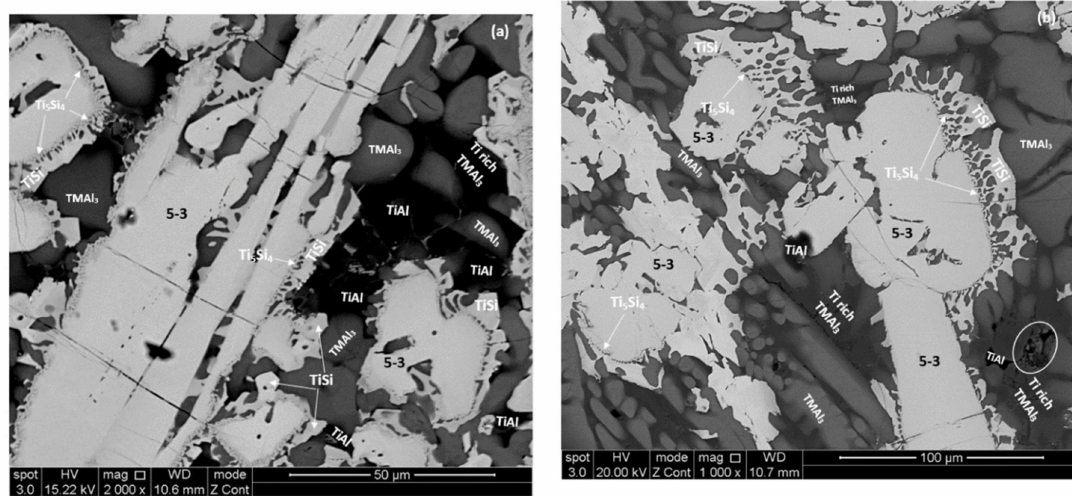
Figure 5. BSE images of the microstructures of the heat treated alloys at 800 ◦ C ( a ) MG5, ( b )